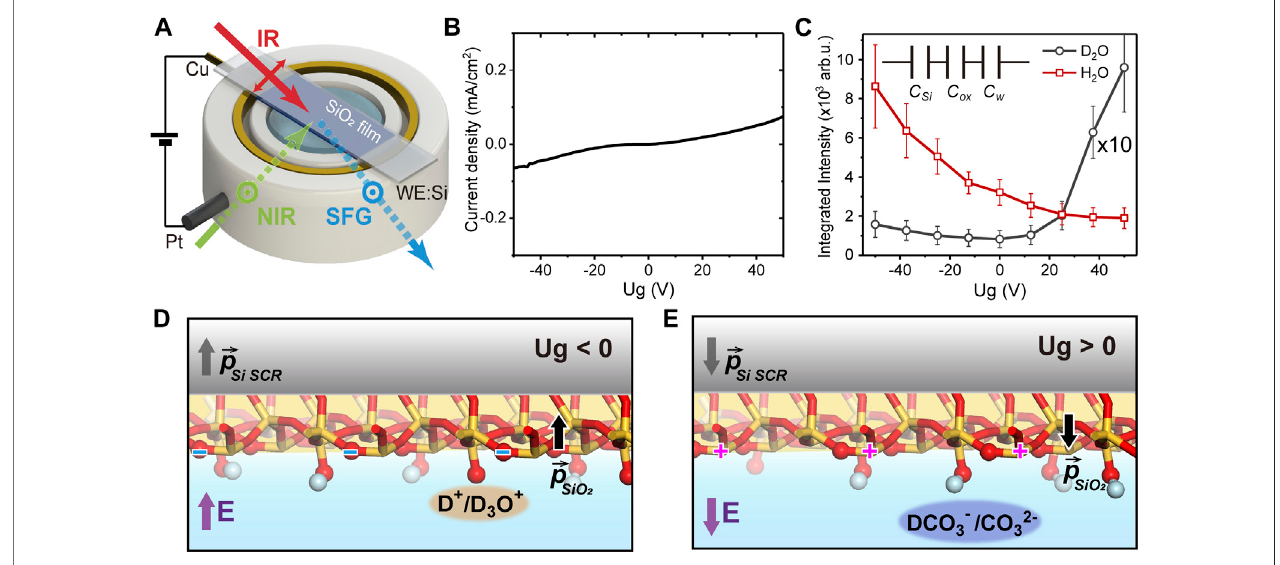
FIGURE1|(A) Sketchoftheexperimental geometry. (B) Theleakcurrentversusthegatepotential( U g ). (C) Thegate-dependentspectrally-integrated SFVSsignal inD 2 O(black,magni fi edby10times)andH 2 O(red).Inset:thecapacitor-in-seriesmodelofthejunction.SketchesoftheinterfacialstructureinD 2 Oexperimentsat (D) U g < 0 and (E) U > 0 g